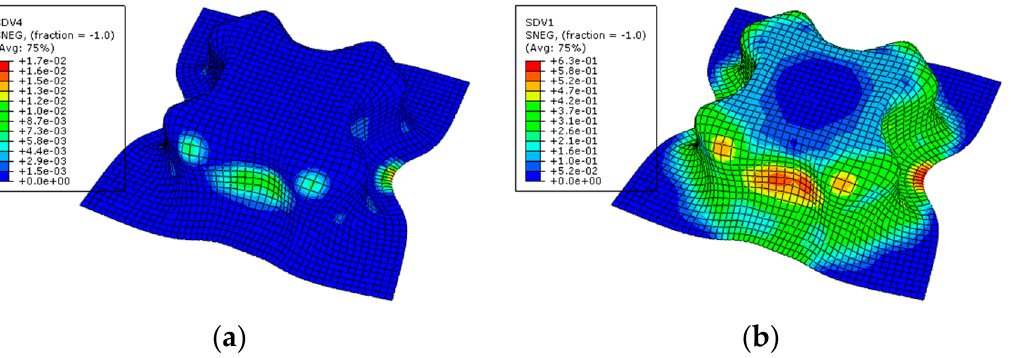
Figure 11. Simulated results of cross-die deep drawing test ( a ) distribution of damage; ( b ) distribution of equivalent plastic stain.